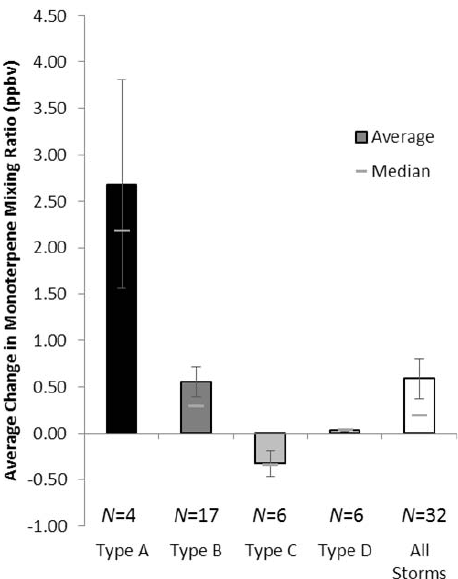
Fig. 7. The median (horizontal lines) and average (bars) change in monoterpene mixing ratios for each type of storm event. Across all events (white bars), there is an average increase of 0.59 ± 0.21ppbv. Amongst the groups identified in the text, Type A (black bars) had increases of 2.68 ± 1.12ppbv, Type B events (dark grey) had increases of 0.55 ± 0.16ppbv, Type C events (grey) decreased by 0.33 ± 0.13ppbv. Type D events (light grey) did not show a mea- surable